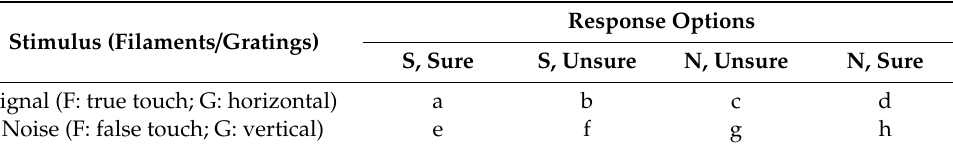
Table 4. Example of the response matrix used to collect data from Von Frey filaments (F) and the gratings orientation (G) test (S = signal and N =